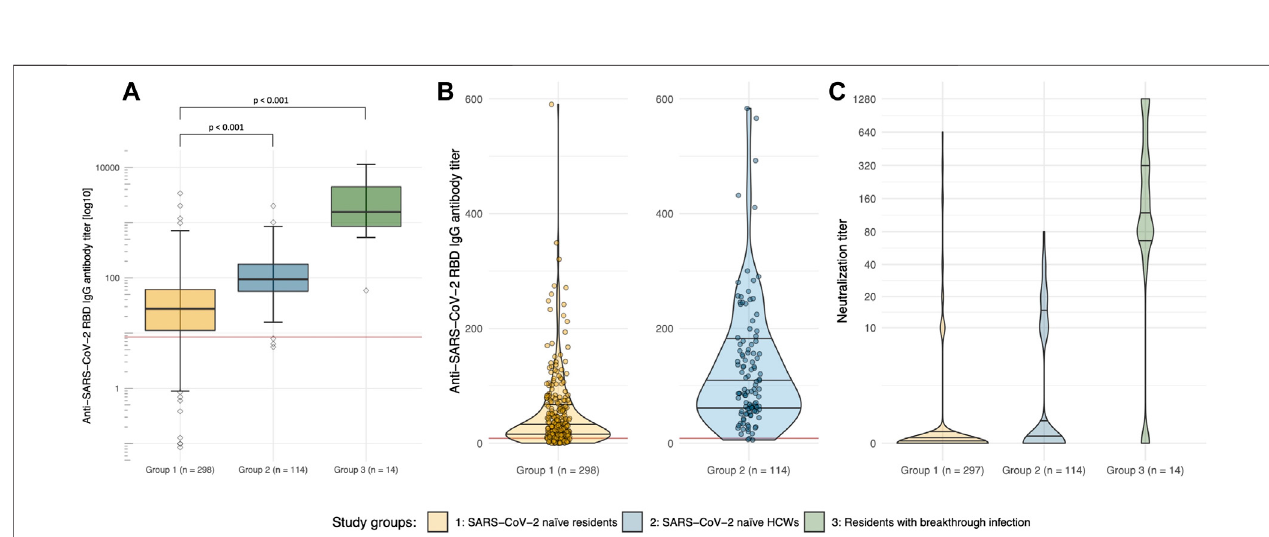
FIGURE 2 | SARS-CoV-2 speci fi c antibody response and neutralization capacity of the Delta variant in elderly LTCF residents. (A) Logarithmic depiction in boxplots, 95% CI and IQR (25 – 75%) of group 1 (residents of LTCFs ≥ 75 years of age; yellow), group 2 (HCWs at LTCFs, 18 – 70 years of age; blue), and group 3 (residents of LTCFs after breakthrough infection; green). Rhomboids represent outliers, the red line displays the cut-off anti-SARS-CoV-2 spike IgG antibody concentration of 8.52 BAU/ml, which is considered a positive test result (borderline: 7.10 – 8.51 BAU/ml). (B) Violin plots for visualization of differences in the non- logarithmic distribution of anti-SARS-CoV-2 spike IgG antibody titers of groups 1 (residents of LTCFs ≥ 75 years of age; orange) and 2 (HCWs at LTCFs, 18 – 70 years of age; blue). (C) Violin plots displaying the different distributions of neutralization titers against the Delta variant between study groups.